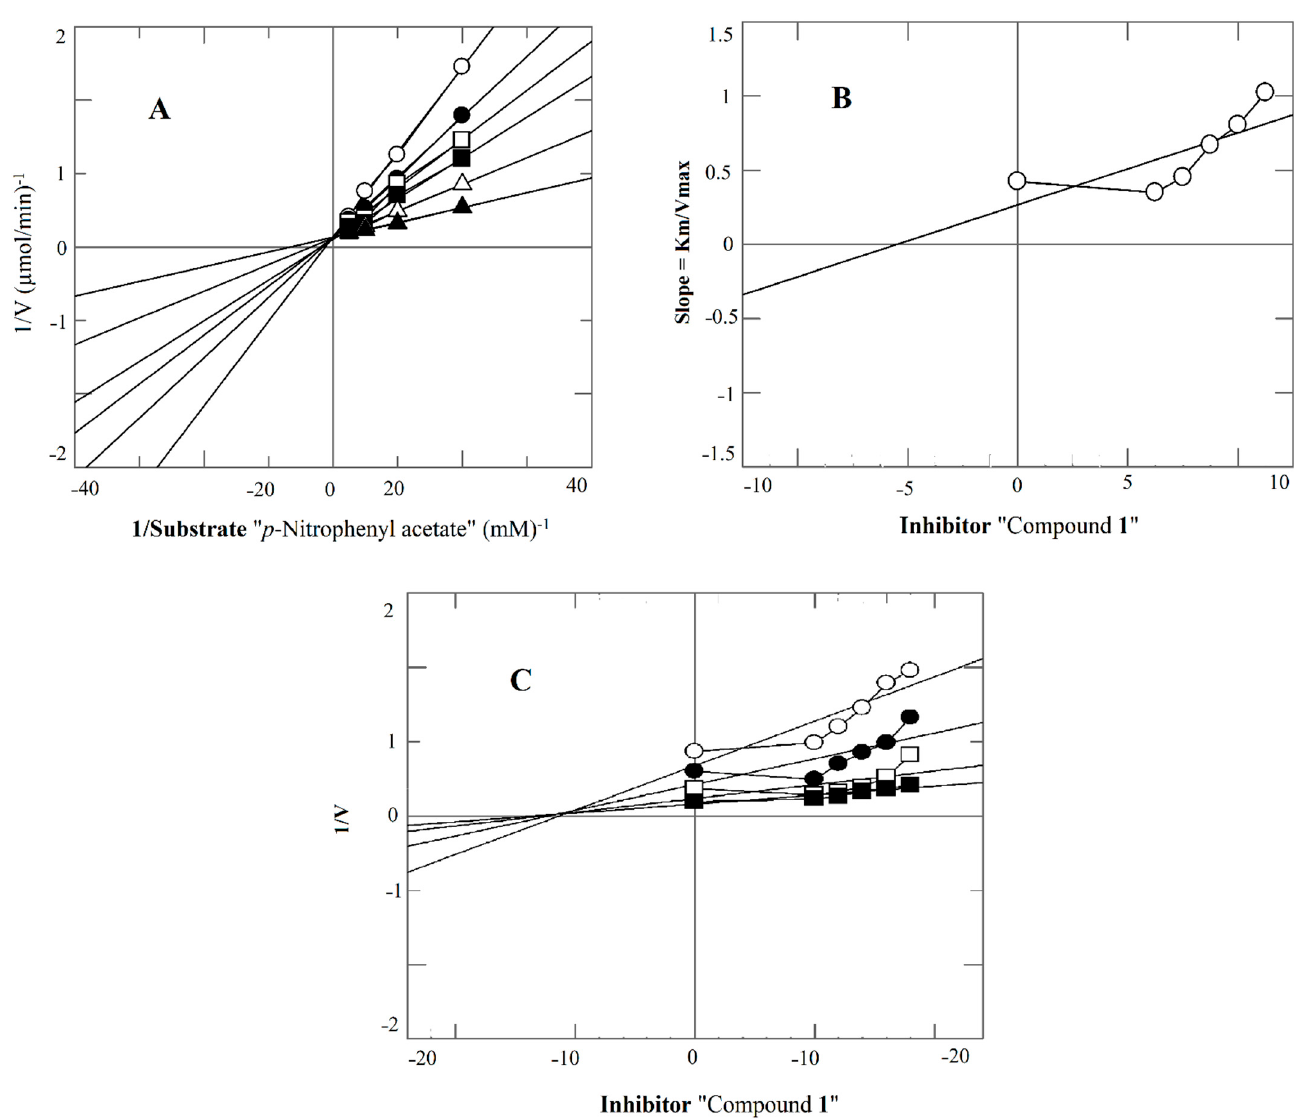
Figure 4. Deducing the type of inhibition of compound 1 against CA-II. ( A ) The first graph is drawn (Lineweaver–Burk plot) between the reciprocal of reaction rate (velocity) vs. reciprocal of substrate ( p-Nitro phenyl acetate ) in the presence of highest dose 25 µM ( ○ ), second highest dose, and so on: 20 µM ( ● ), 15 µM ( □ ), 10 µM ( ■ ), 5 µM ( ∆ ), and negative control ( ▲ ) of compound 1 . ( B ) The second graph is (Lineweaver–Burk plot) between the gradient of each line vs. different concentrations of inhibitor “compound 1 ”. ( C ) The third graph “Dixon plot” is drawn between reciprocal of reaction rate (velocities) vs. different concentrations of inhibitor “compound 1 ”.